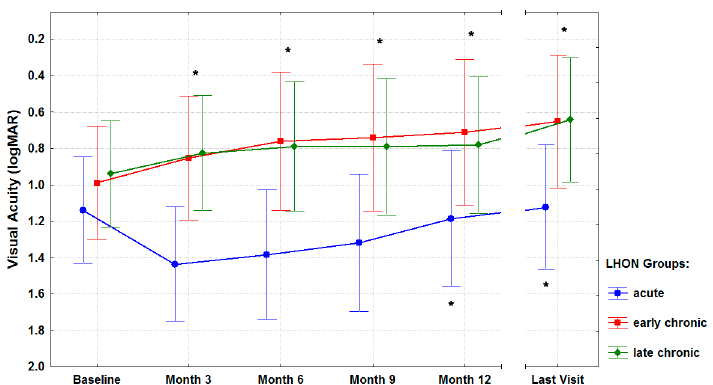
Figure 1. Visual acuity over time in the different groups of LHON patients treated with idebenone. Time from LHON onset at treatment initiation was <1 year in acute patients, 1–5 years in early chronic patients and >5 years in late chronic patients. Data are presented as least square means and 0.95 confidence intervals; logMAR scaling was reversed to depict an increase as an upward shift. * Statistically significant changes from nadir or baseline in acute and chronic groups, respectively ( p < 0.05, ANOVA).